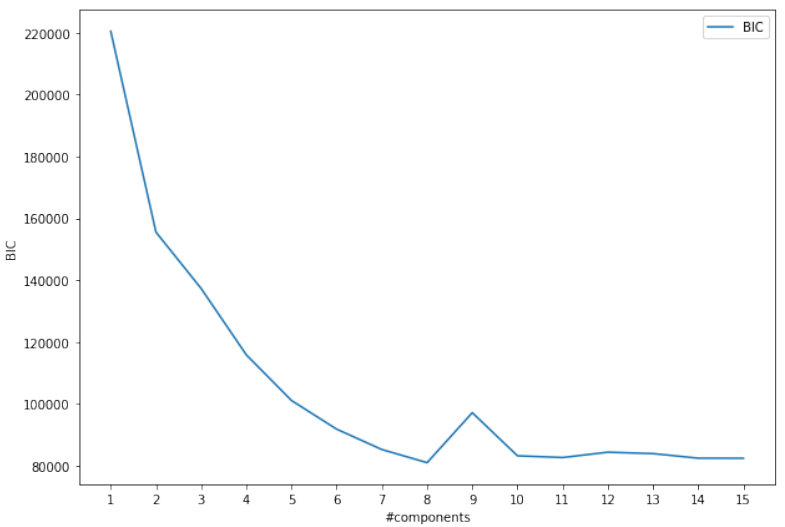
Figure 6. Bayesian Information Criterion test for the number of Gaussian models that fit our